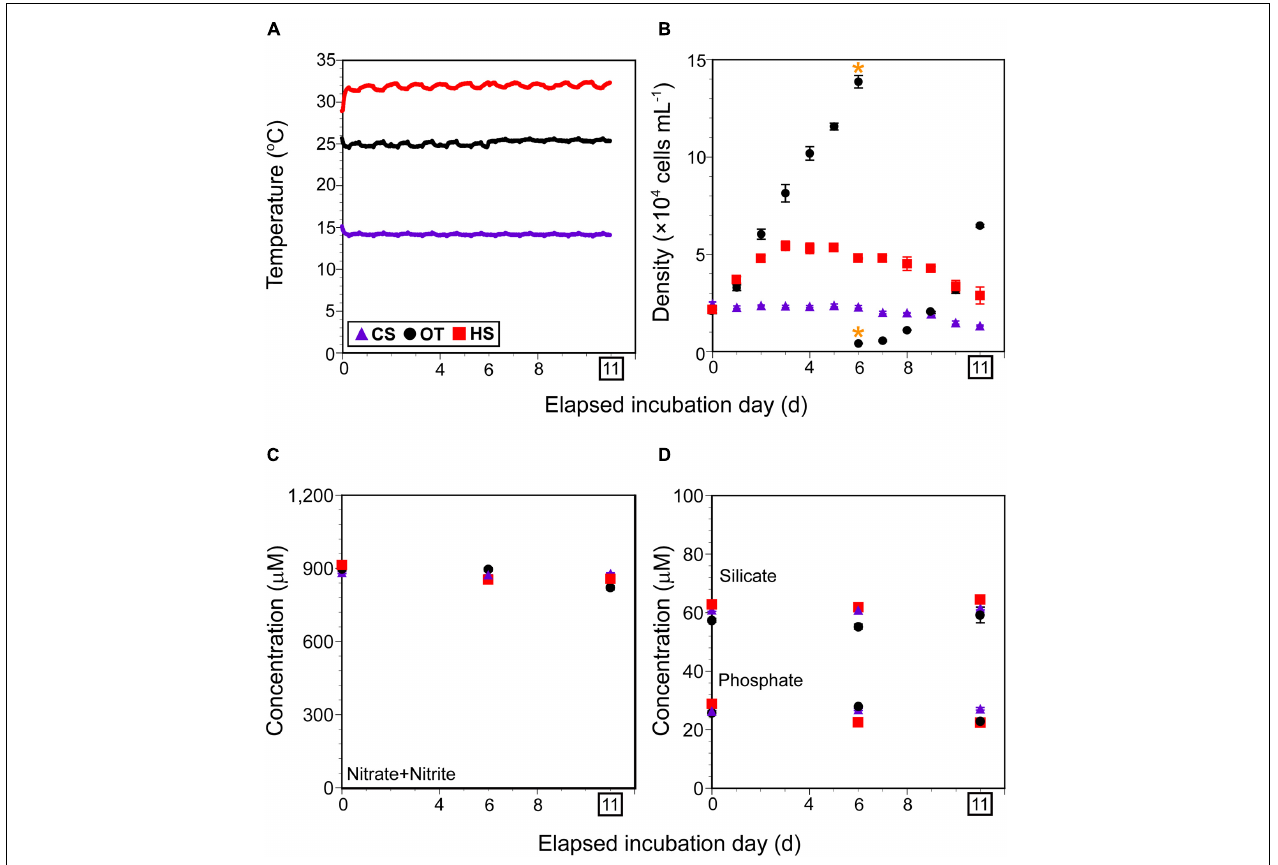
FIGURE 1 | Incubation condition and cell density of Biecheleriopsis adriatica during the incubation. (A) Temperature ( ◦ C) as a function of elapsed incubation day in each temperature-controlled chamber monitored using HOBO data loggers for cold stress (CS), heat stress (HS), and optimal temperature (OT). (B) Average B. adriatica cell density ( × 10 4 cells mL − 1 ) in the triplicate flasks as a function of elapsed incubation day under CS, HS, and OT. Yellow asterisks indicate the day on which cultures were transferred into new flasks at OT. (C,D) Average concentration ( µ M) of nitrate plus nitrite, silicate, and phosphate in the triplicate flasks at days 0, 6, and 11 under each temperature condition. After incubating for 11 days under each condition, B. adriatica cells were harvested for RNA sequencing. Purple triangles, black circles, and red rectangles indicate CS, OT, and HS data points, respectively. Vertical symbols represent treatment means ± 1